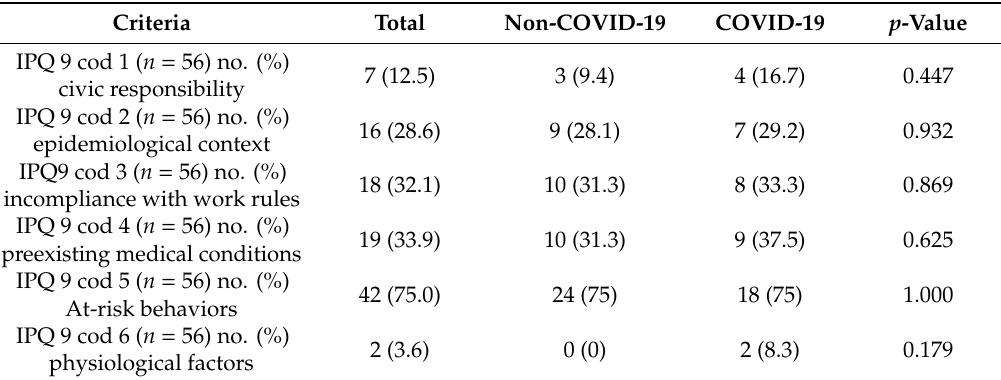
Table 2. IPQ 9 item in COVID-19 and non-COVID-19